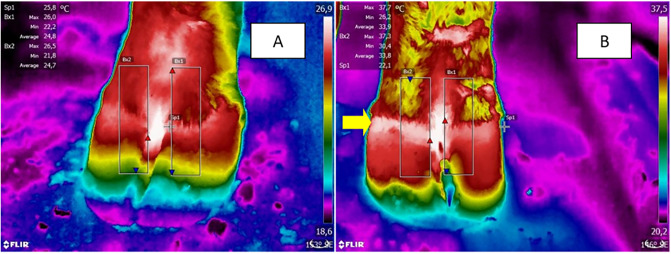
Infrared thermography of the left thoracic limb at baseline (A) and after experimentally induced laminitis (B).The white area indicated by the yellow arrow in the region of the coronary band indicates area of higher temperature.